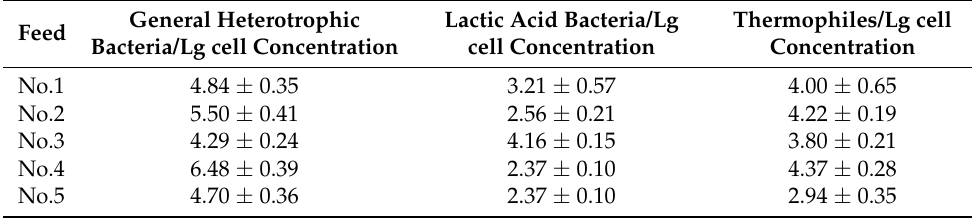
Table A2. Bacterial concentration of feed before 60 Co irradiation. ( n = 3; cfu/g).